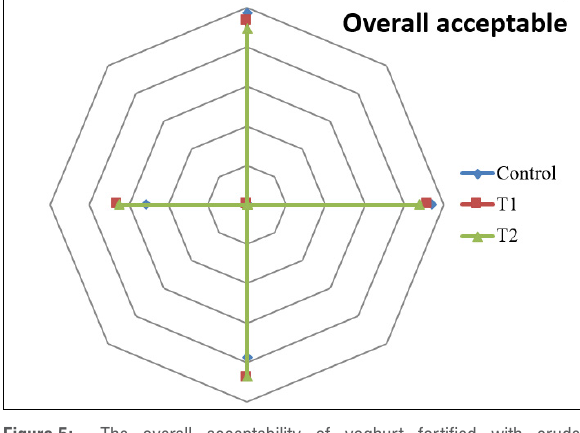
The overall acceptability of yoghurt fortified with crude fucoxanthin during 21 days of cold storage. Control: plain yoghurt; T1: yoghurt containing 20 mg crude fucoxanthin / kg milk; T2: yoghurt containing 30 mg crude fucoxanthin / kg milk. Data are expressed as a mean of three replicates ±